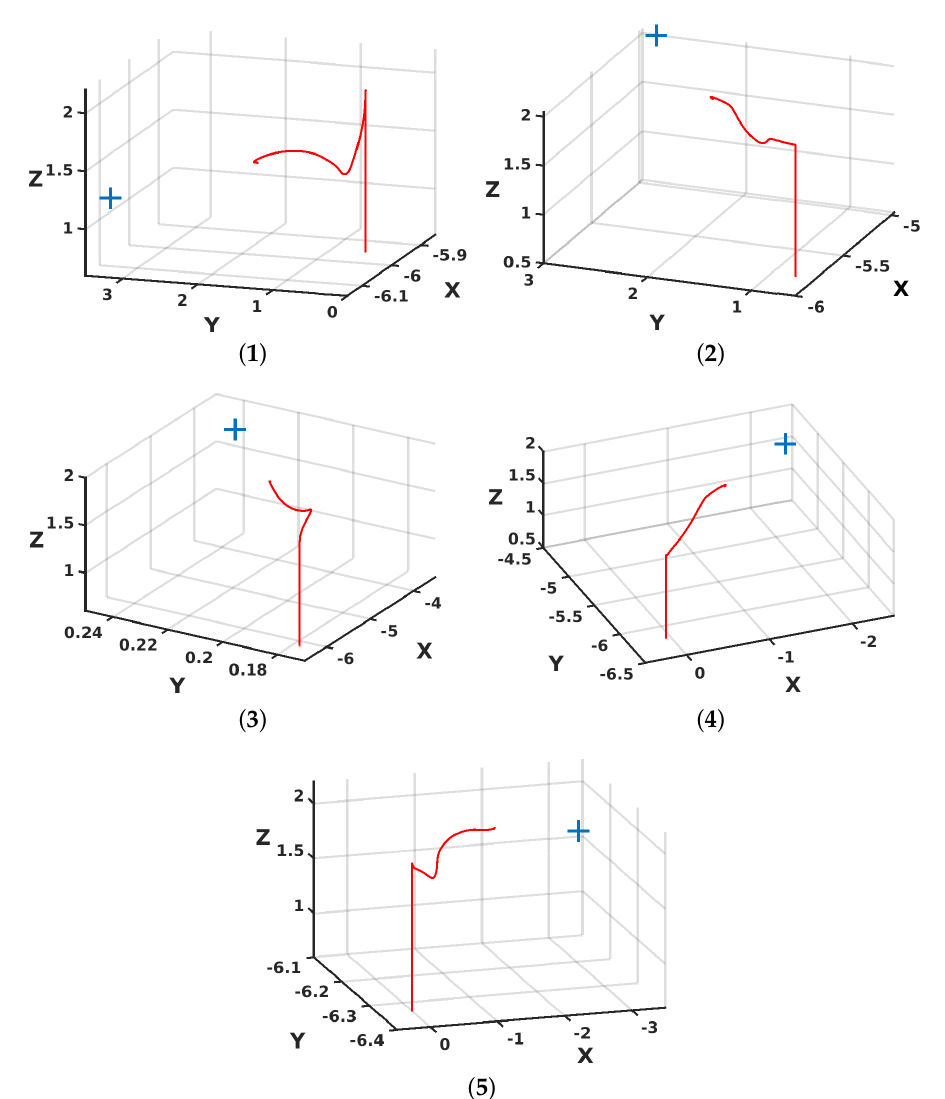
Figure 22. Trap position in relation to the UAS and UGV initial position. ( 1 ) Trap at 70 degrees left. ( 2 ) Trap at 30 degrees left. ( 3 ) Trap at center. ( 4 ) Trap at 30 degrees right. ( 5 ) Trap at 70 degrees